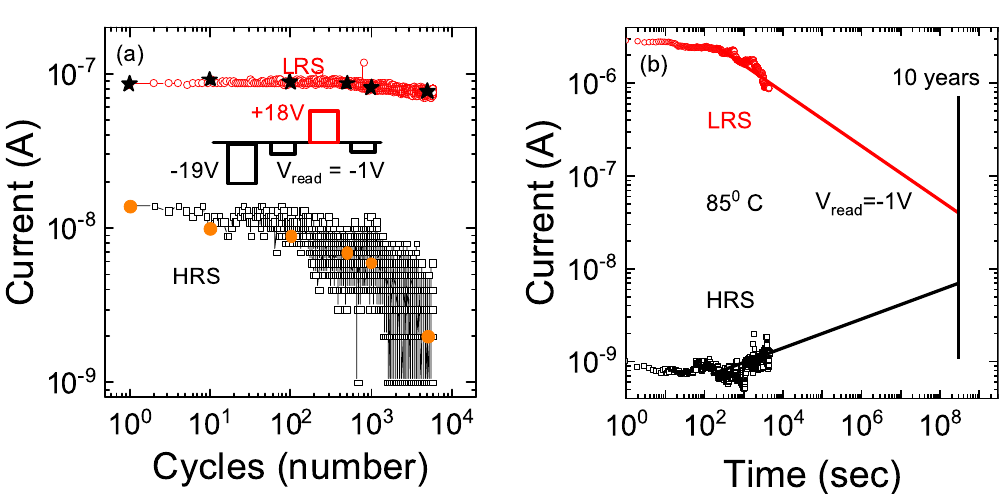
Figure 3. ( a ) Endurance of p + -Si/SiN x /Ni memristor cycles. ( b ) Retention of p + -Si/SiN x /Ni memristor cycles at 85